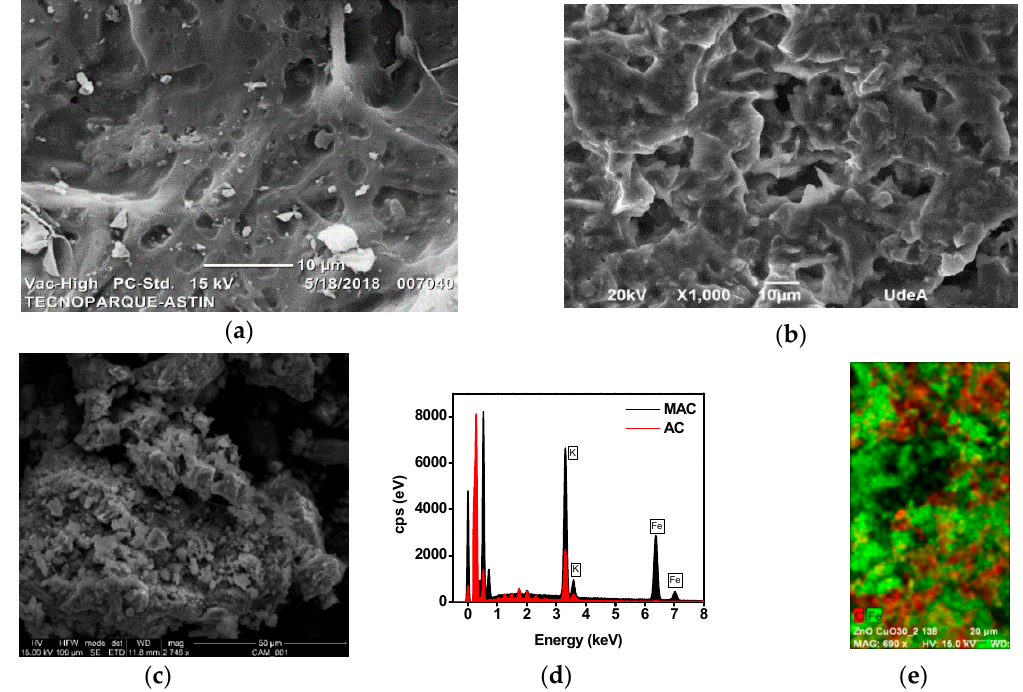
Figure 1. SEM images of ( a ) C, ( b ) activated carbon (AC), ( c ) and magnetic AC (MAC), ( d ) EDS spectra and ( e ) mapping.